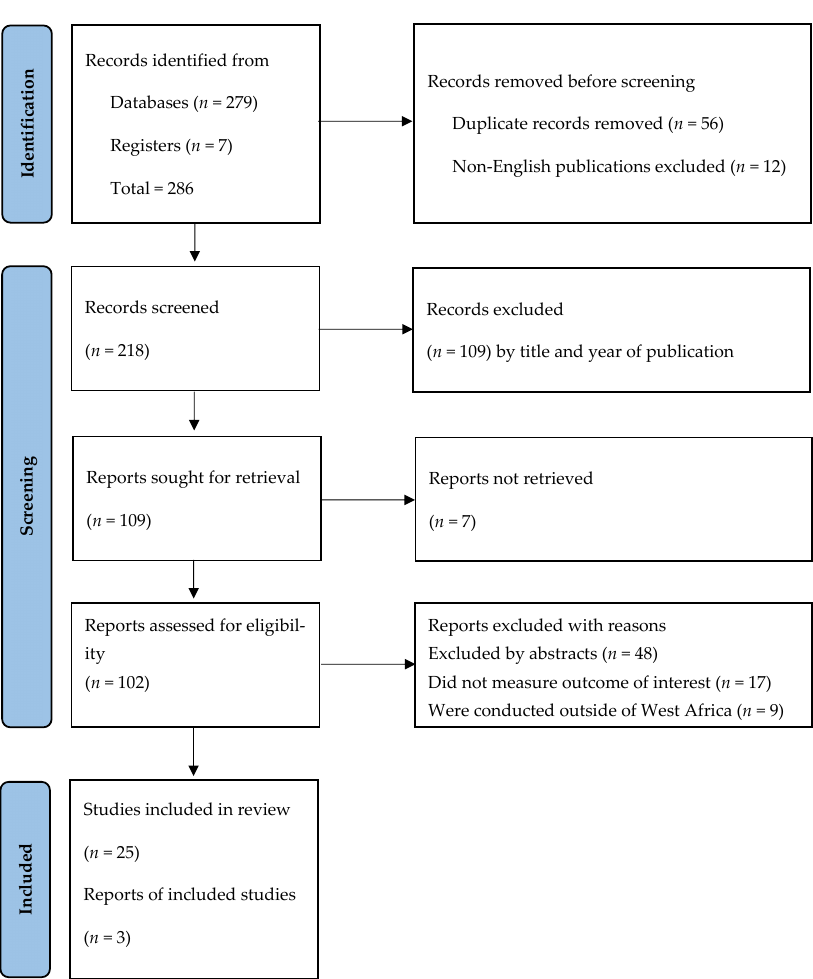
Figure 1. PRISMA flowchart of search results.